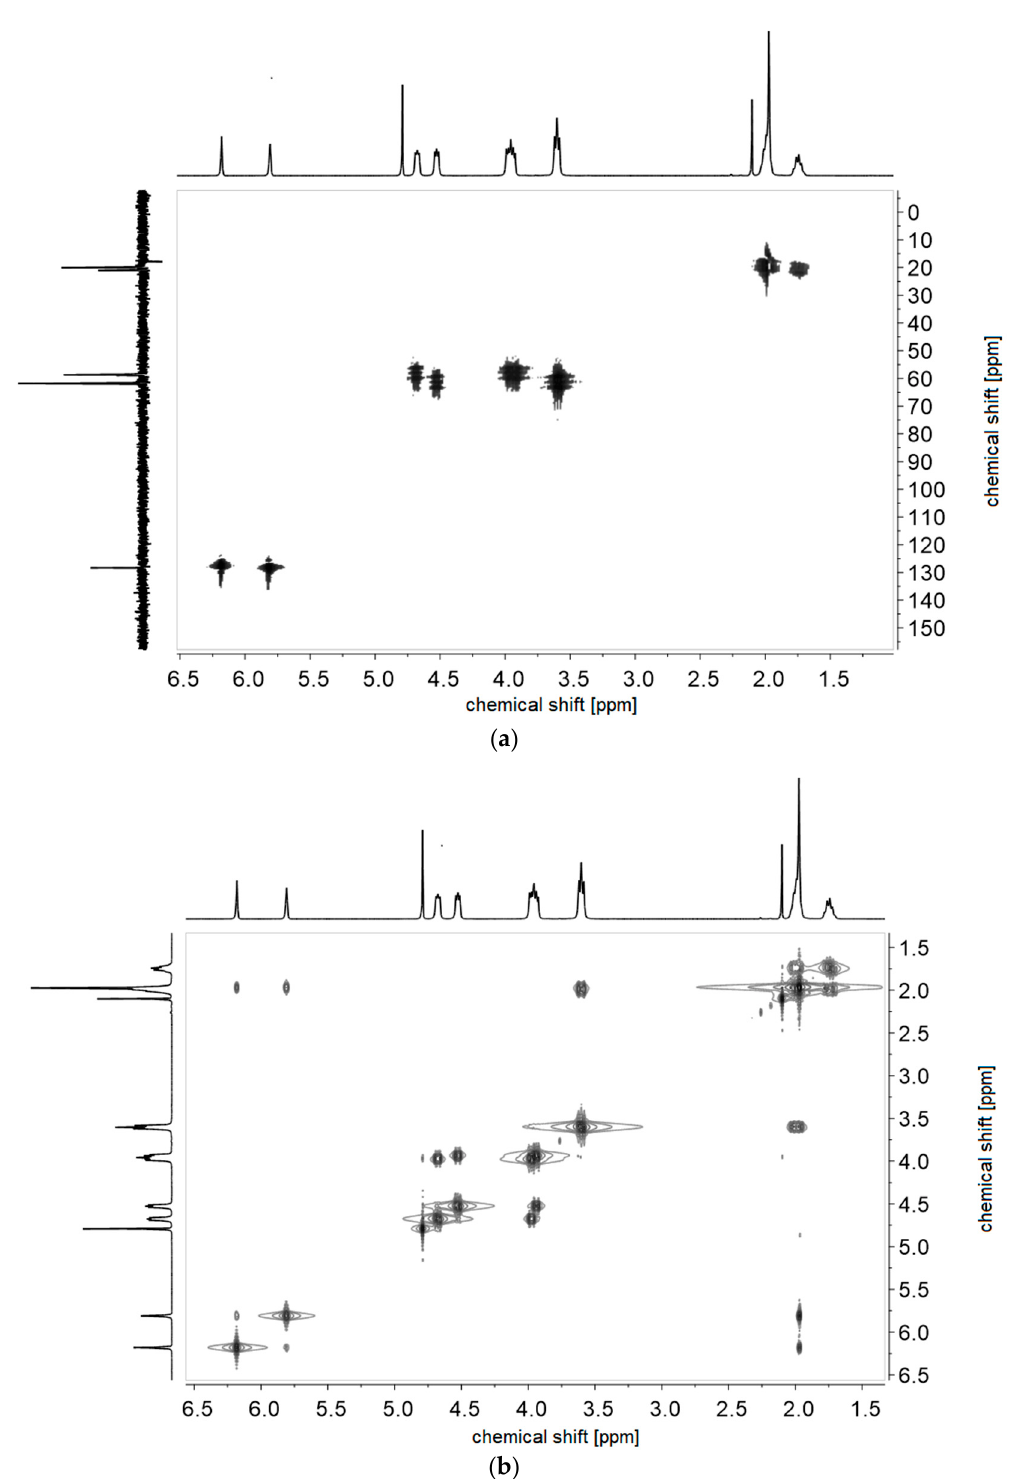
Figure A6. ( a ) 1 H- 1 H-COSY- and ( b ) 1 H- 13 C-HMQC NMR-spectra of monomer of 4c in D 2 O.